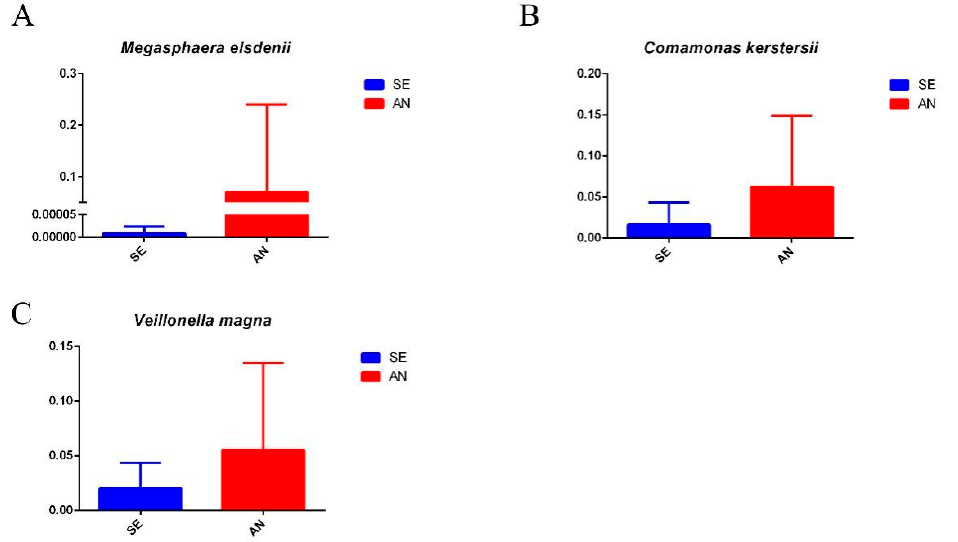
Figure 9. Relative abundance of the Megasphaera elsdenii bacterial species ( A ), Comamonas kerstersii bacterial species ( B ), and Veillonella magna bacterial species ( C ) between the AN and SE samples.